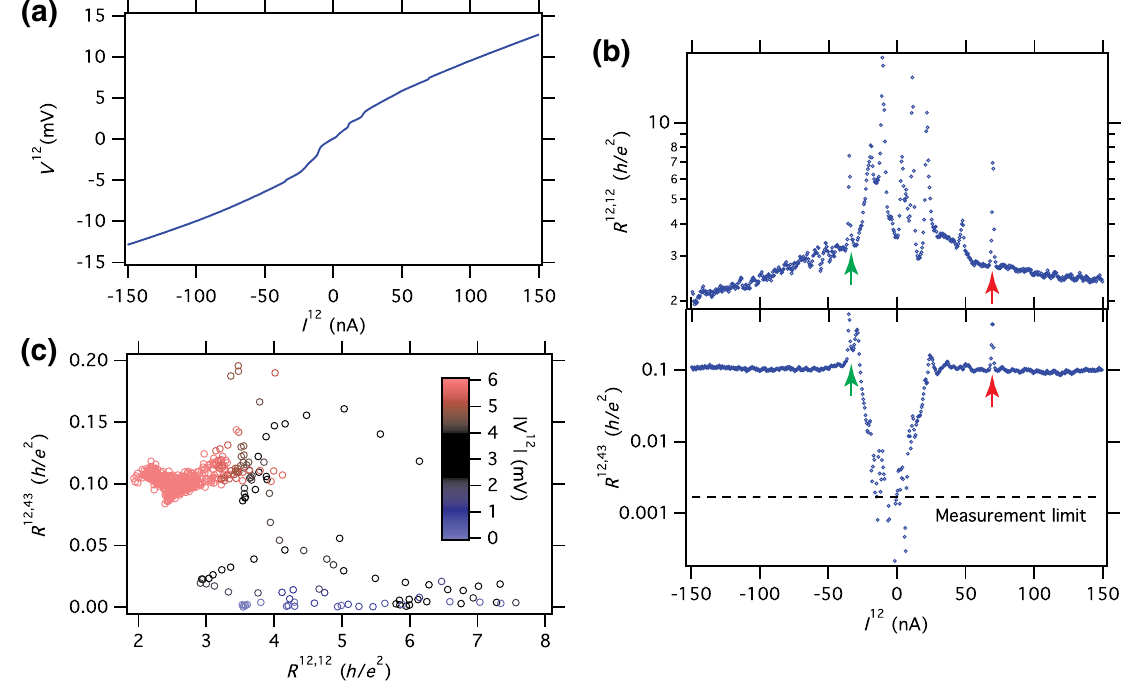
FIG. 5. Correlations between local and nonlocal transport at T ¼ 70 mK and H ¼ 0 Oe . (a) Local I - V curve showing nonlinear response. (b) Local differential resistance (top panel) with several sharp features and nonlocal resistance (bottom panel) which drops by 2 orders of magnitude at sufficiently small I 12 . There are many correlations between the local transport between leads 1 and 2 and the nonlocal voltages that appear at leads 3 and 4. Such correlations are indicated by green and red arrows. (c) Parametric plot of local and nonlocal resistance for various current values I 12 . The local resistance is larger when the nonlocal resistance is small, and vice